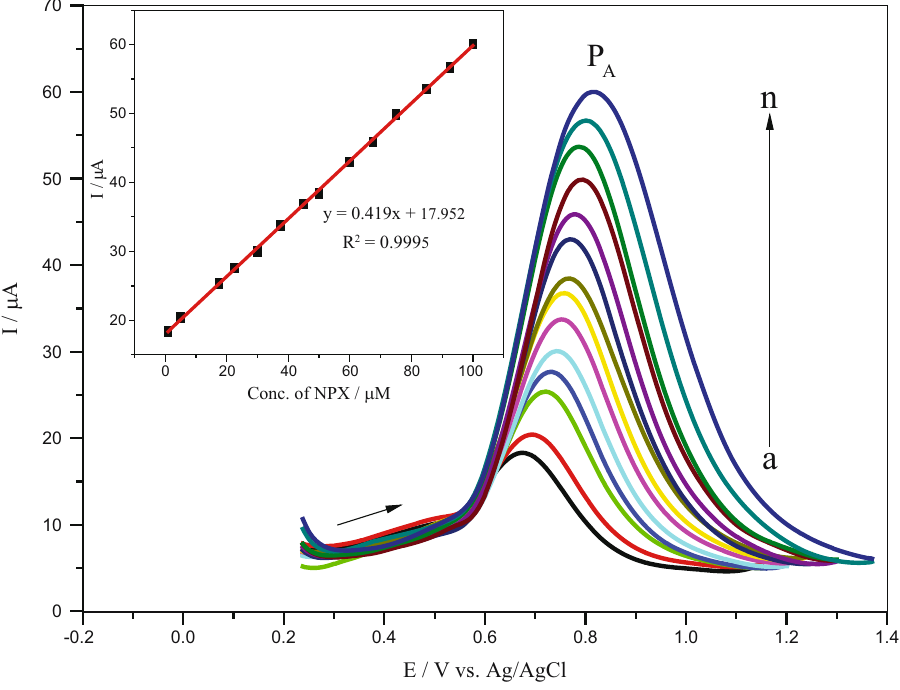
Figure 7: DPVs at the poly ( r - o - NBA ) /GQDs/CPE for di ff erent concentrations of NPX from a to n ( 1.0, 5.0, 17.5, 22.5, 30.0, 37.5, 45.0, 50.0, 60.0, 67.5, 75.0, 85.0, 92.5, and 100 µM in 0.1 M PBS [ pH = 7.0 ]) . Pulse amplitude, 25 mV; pulse width, 50 ms; and scan rate, 20 mV · s − 1 . Inset: the plot of the peak current versus NPX concentration.